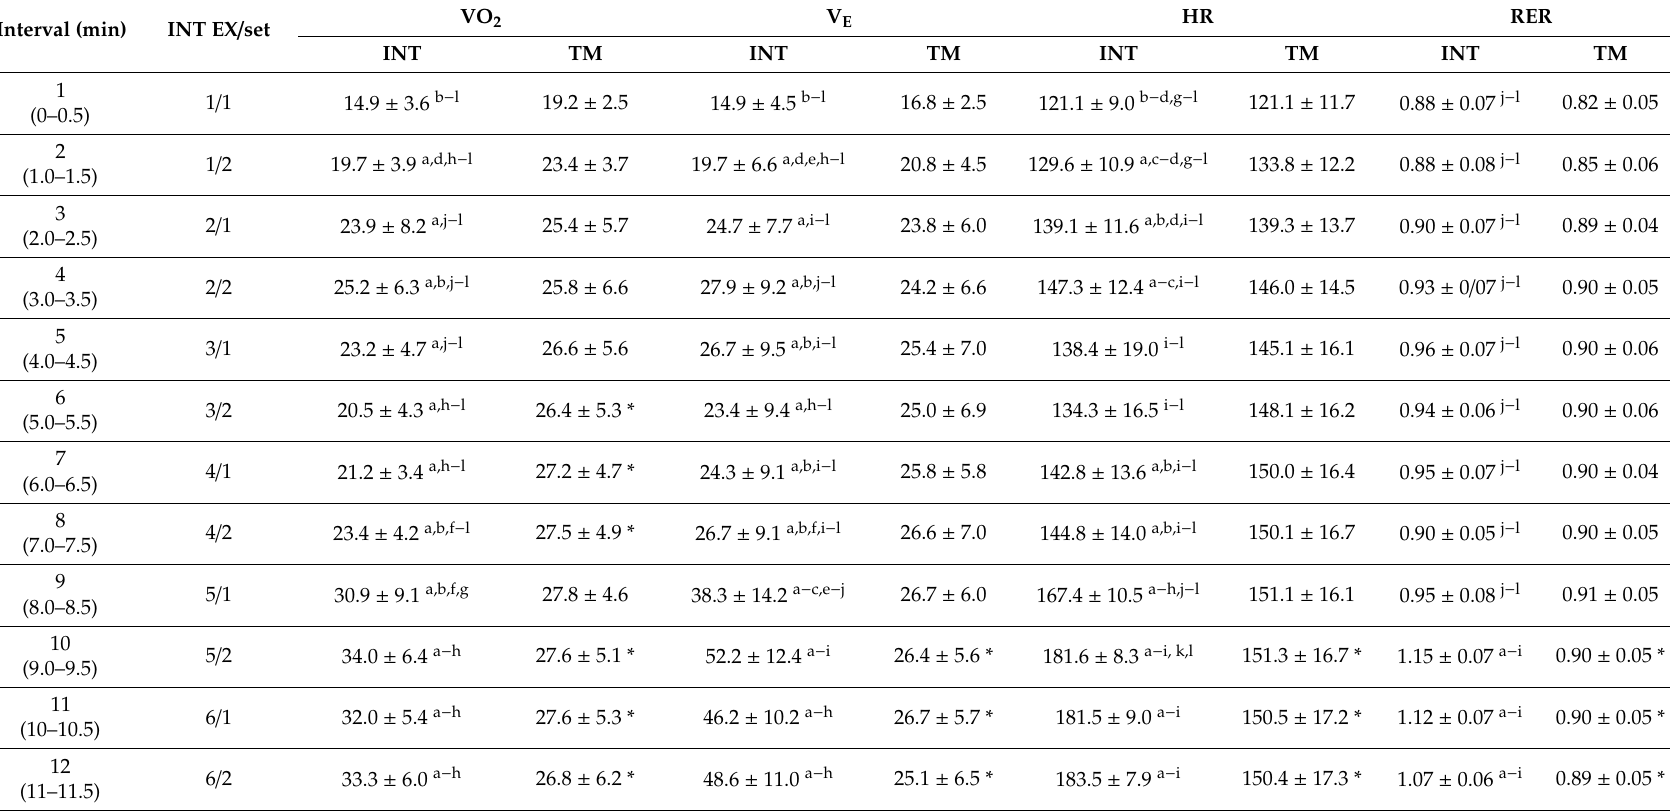
Table 1. Cardiometabolic responses during integrative neuromuscular training (INT) and treadmill (TM)